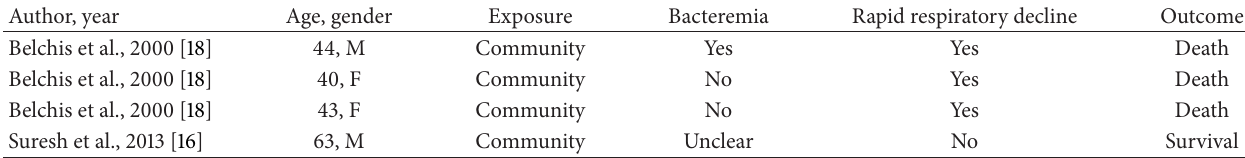
Table 1: Summary of case reports of necrotizing pneumonia due to Burkholderia cepacia complex species in non-cystic fibrosis